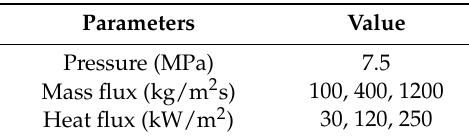
Table 1. Parameters used for the simulation.